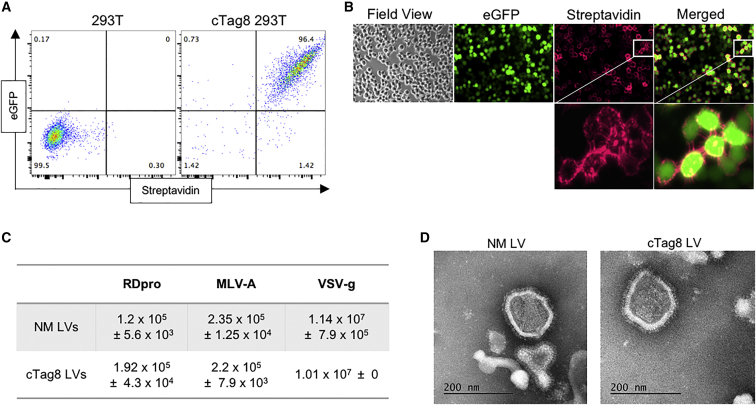
Generation of cTag8-Expressing 293T Cells for Modified Vector Production(A) Both 293T (non-transduced) and 293T cells expressing cTag8 (cTag8 293T) by γ-retroviral transduction with cTag8 co-expressed with EGFP were stained with streptavidin-APC for cTag8 expression analysis by flow cytometry. (B) Surface expression analysis of cTag8 by immunofluorescence staining of cTag8 293T cells with streptavidin-APC. Engineered cells were assessed for LV packaging capacity by the production of LVs from both 293T cells (non-modified, NM LVs) and cTag8 293T cells (cTag8 LVs) in plain DMEM, pseudotyped with either RDpro, MLV-ampho, or VSV-G glycoproteins. (C) Viral supernatants were frozen, viral titers (infectious units (IU)/mL) of stocks were determined by infectivity assay, and mean values are presented ± SD of triplicate determinations. (D) Sucrose-cushion-ultracentrifuge-purified VSV-G pseudotyped NM LVs and cTag8 LVs were negatively stained and analyzed by transmission electron microscopy (TEM). Scale bars, 200 nm.